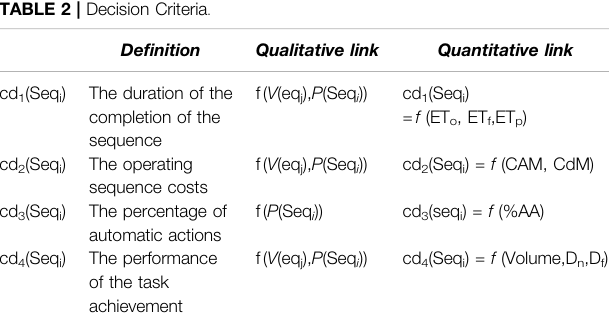
TABLE 2 | Decision Criteria . De fi nition Qualitative link Quantitative